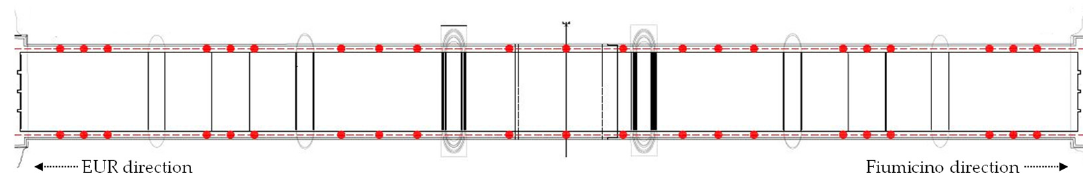
Figure 19. Configuration of a possible SHM system designed for “ Ponte della Magliana ”.